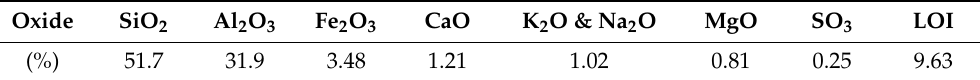
Table 1. Chemical compositions of fly ash class F.